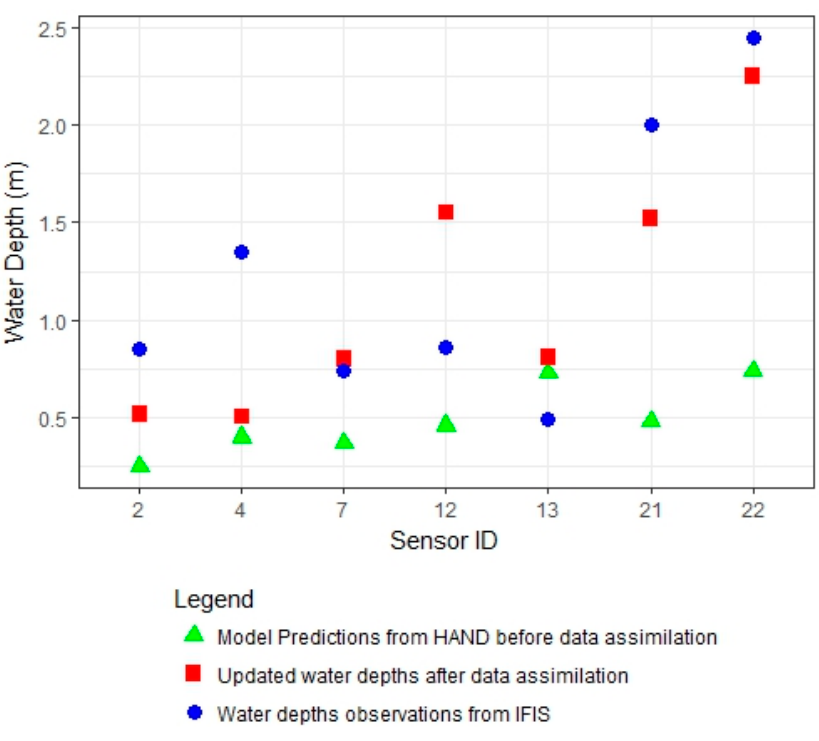
Figure 4. Water depth at each sensor location. Table 2. Water depth before and after data assimilation compared with water depth measurement from the Iowa Flood Information System (IFIS) for training and testing